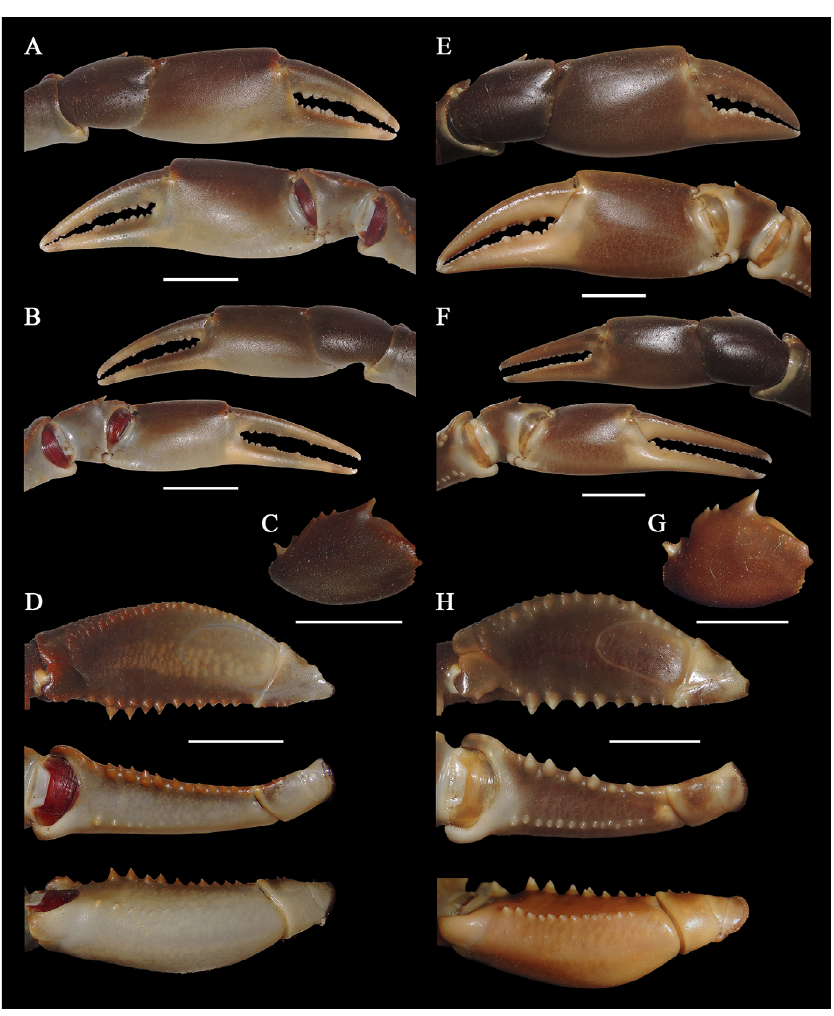
Figure 8. Chelipeds of an adult male Epilobocera capolongoi (CZACC 5.0047) ( A – D ) and of an adult male E. cubensis (CZACC 5.0050) ( E – H ) from Lomas de Banao Ecological Reserve. A , E , Right chela in outer (above) and inner (below) views; B , F , left chela in outer (above) and inner (below) views; C , G , right carpus in dorsal view; D , H , right merus in dorsal (above), inner (middle), and inner-lower (below) views. All the images were taken soon after death (keeping the coloration in life), except G and H below (after preservation). Scale bars = 10 mm.